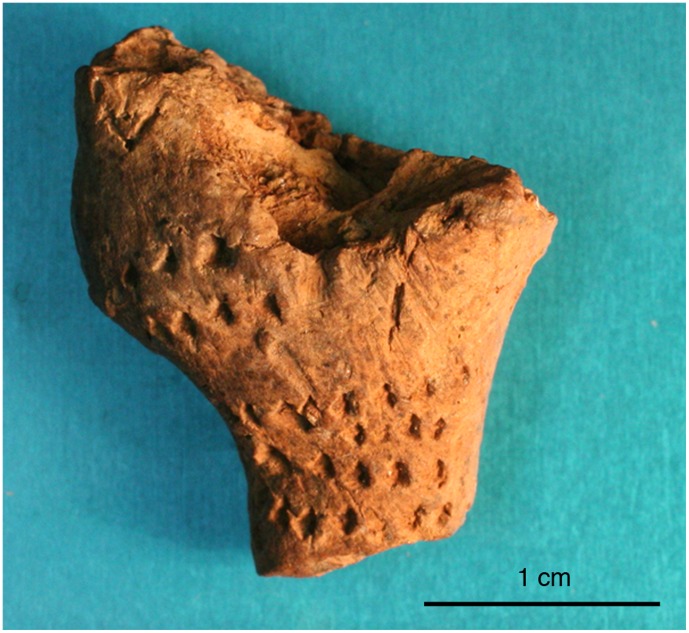
Photograph of C2.